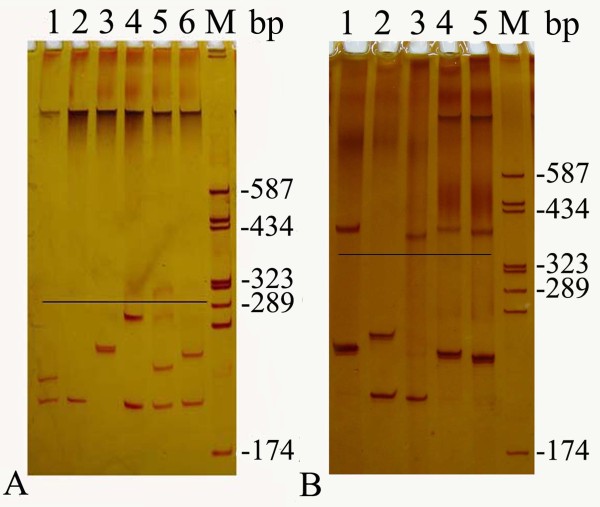
The polyacrylamide gel electrophoresis analysis of ANs (A) and alleles of SCA patients (B). In figure 2A, lanes 1-5 were normal individuals. The black line indicates the upper limit of ANs. In figure 2B, lanes 1, 3, 4, and 5 were MJD patients; lane 2 was an SCA patient, but not a MJD patient. The black line indicates the place of the lower limit of expanded alleles. M: pGEM-3Zf (+) DNA-Hae III marker.